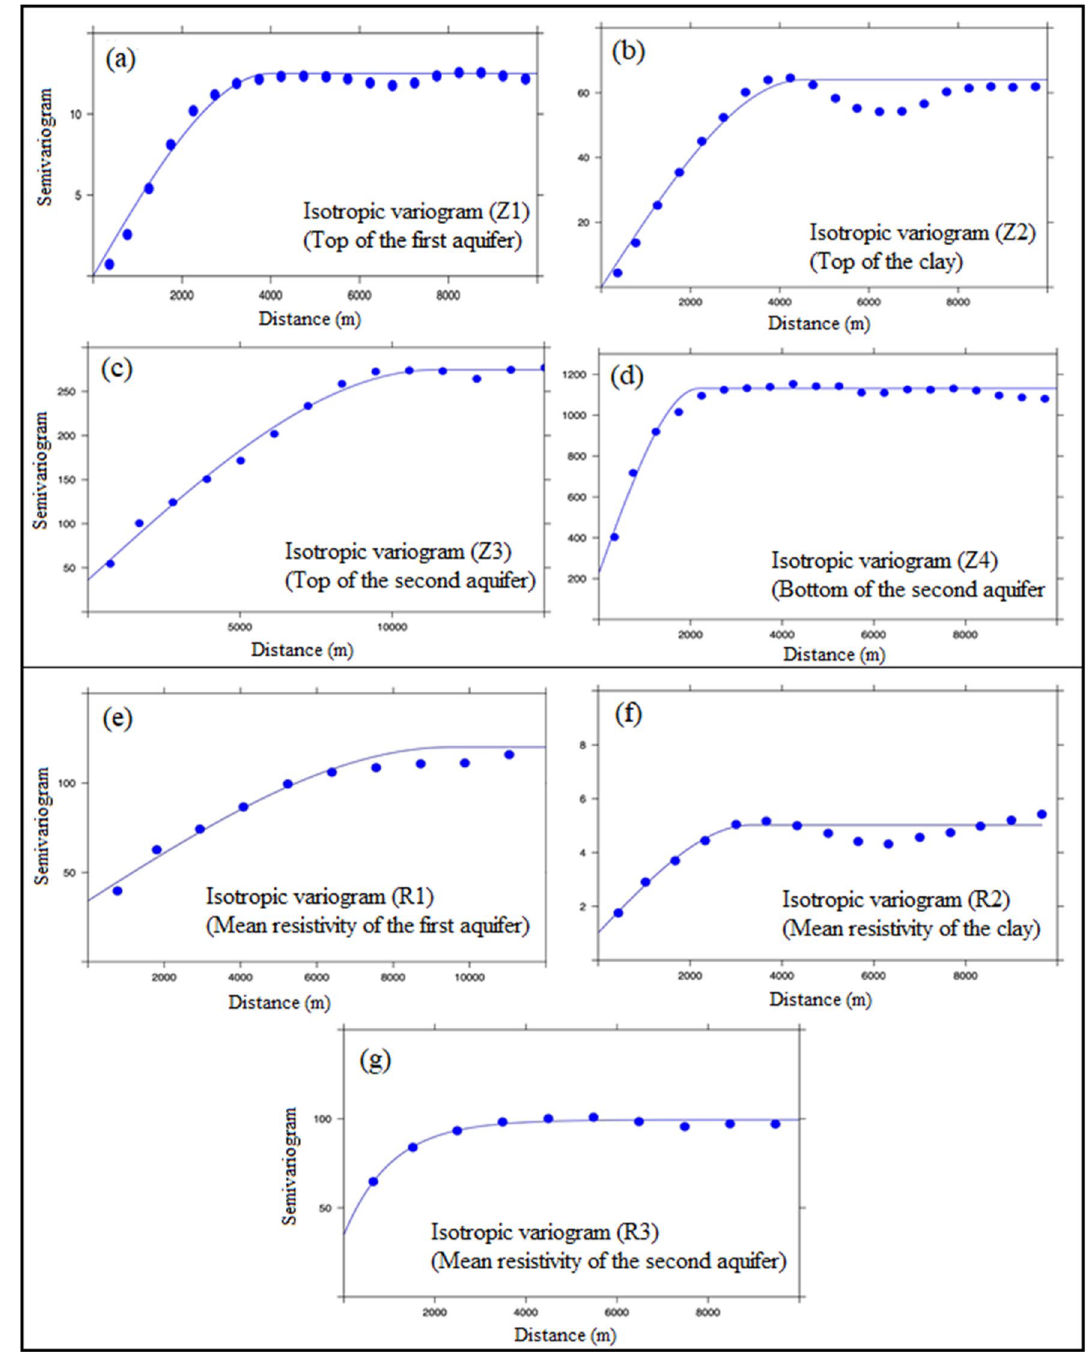
Figure 2. Variograms of ( a ) Z1: top of the first aquifer, ( b ) Z2: top of clay, ( c ) Z3: top of the second aquifer, ( d ) Z4: bottom of the second aquifer, ( e ) R1: mean resistivity of the first aquifer, ( f ) R2: mean resistivity of the clay, and ( g ) R3: mean resistivity of the second aquifer of multi-aquifer system in a part of Ganga basin, Patna, Northern which was highest in number as compared to the other 3 parameters, and also variance in the data set was least. Also, Z4 i.e., the base of the second aquifer, exhibits the most variance (Table 1), maximum RMSE of 24.25, and minimum R 2 value of 0.70 (Table 2), giving rise to the conclusion that data input and quality for Z4 was least amongst all. The above cross-validation results show that the chosen model and its parameters are adequate. The model fitting for the empirical variogram was carried out using the weighted least square method, and the search radius for three parameters was 10 km, but for Z3, it was 15 km because of the higher data density in the HTEM surveyed area.